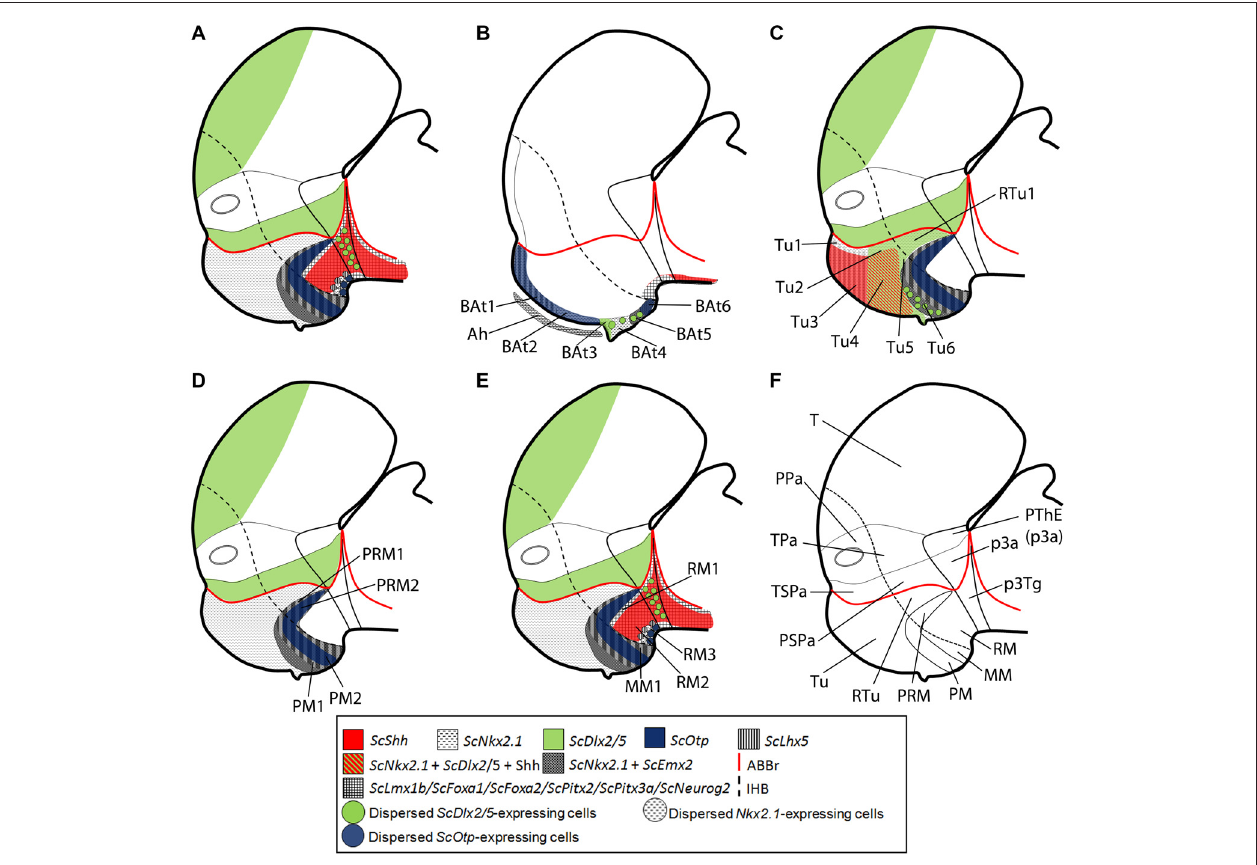
FIGURE 6 | Schematic representation of the catshark basal hypothalamus genoarchitecture. All schemes represent parasagittal sections except (B) that represents a medial sagittal section. (A) Global organization of catshark hypothalamus. (B) Basal acroterminal (BAt) territory and corresponding microzones. The expression of ScNkx2.1 , ScOtp , ScLhx5 , ScDlx2/5 and ScEmx2 defines six microzones (BAt1–6). BAt1–2 are coextensive with adenohypophysis suggesting a signaling influence. BAt3 corresponds to neurohypophysis. BAt4 give rise to saccus vasculosus . BAt5–6 are involved in posterior recess organ development. (C) Tu/RTu subdomains